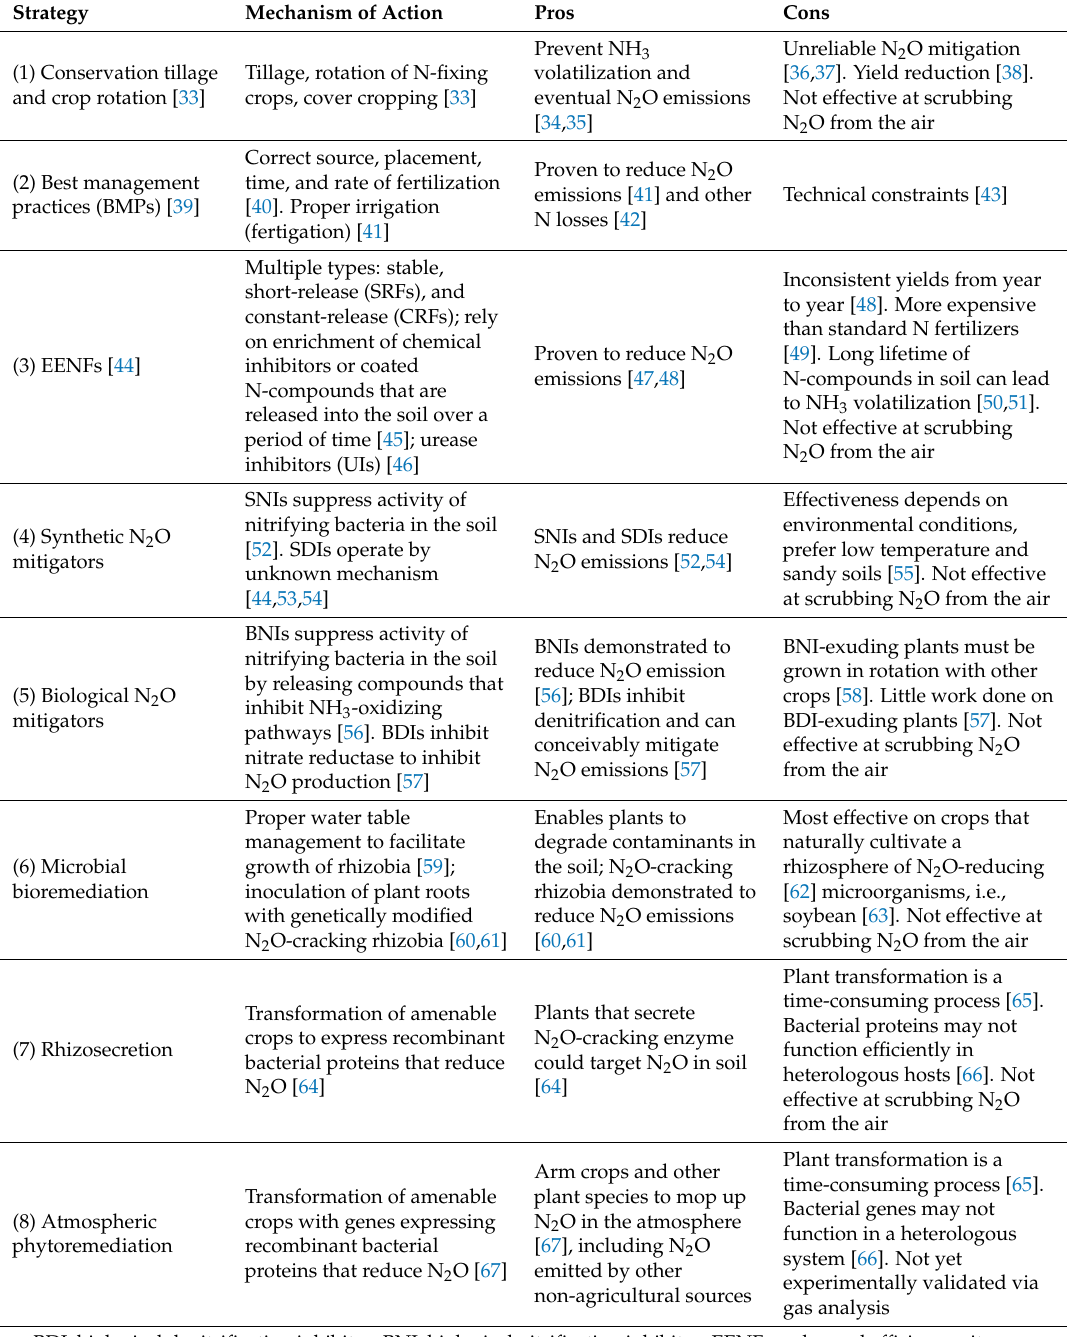
Table 1. Summary of current N 2 O mitigation